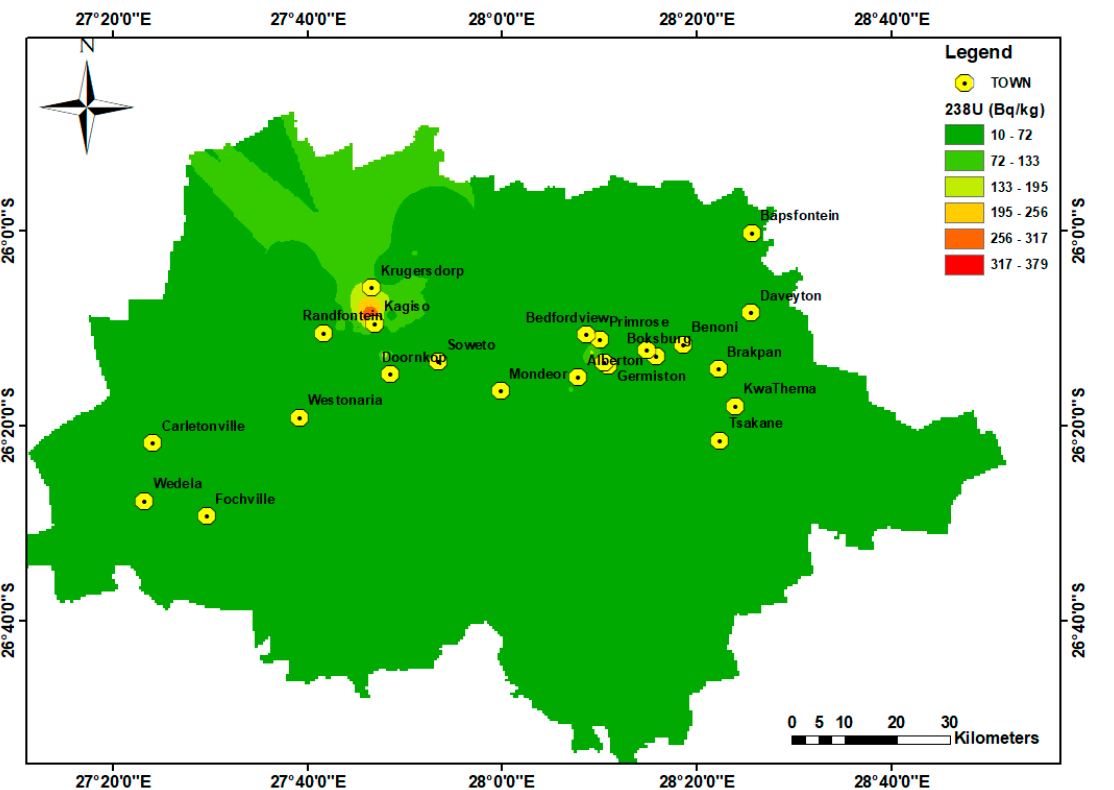
Figure 9. Spatial activity distribution map of 232 Th (Bq/kg).